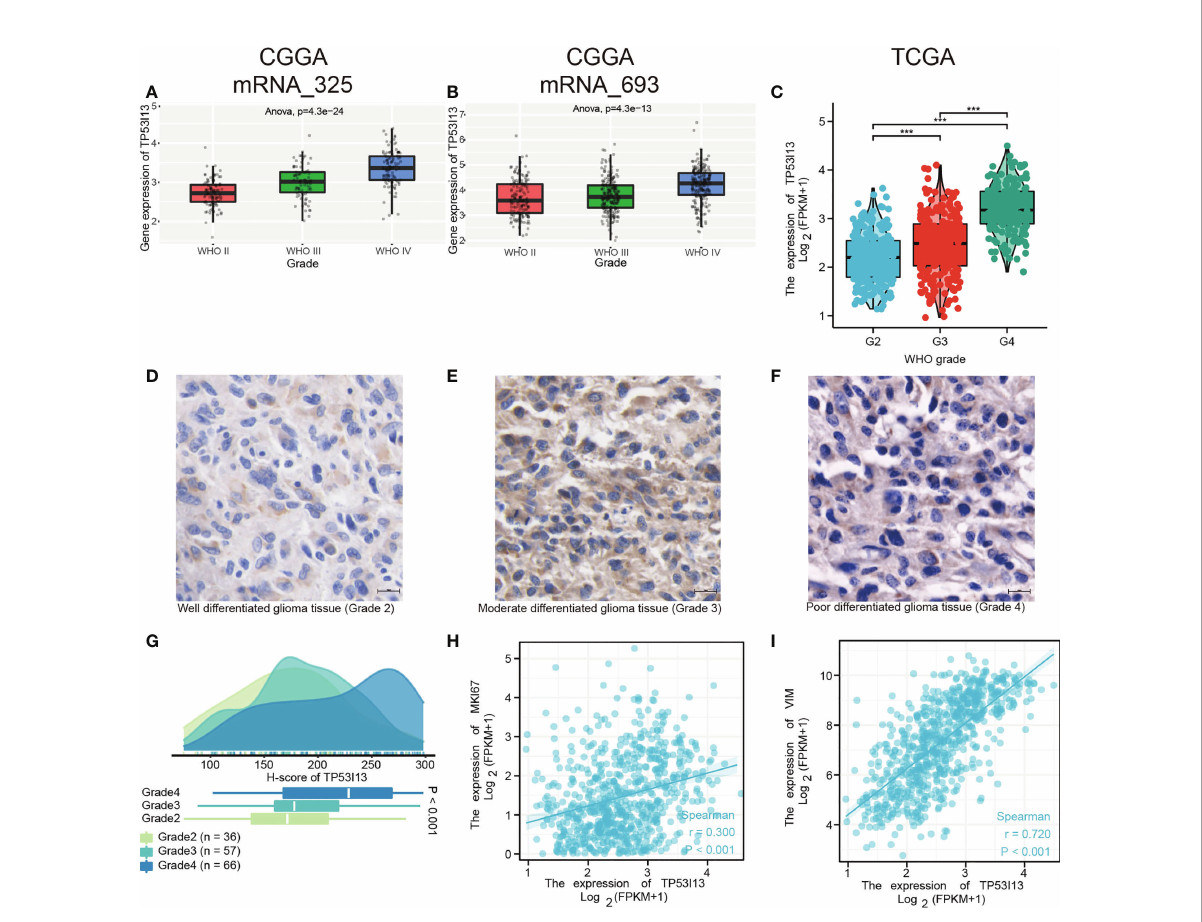
FIGURE 4 TP53I13 Expression in subgroups of glioma patients based on IDH mutation status, WHO grade, and 1p/19q codeletion status. Boxplot shows a correlation between TP53I13 expression and WHO grade based on (A) the CGGA mRNAseq_325 dataset, (B) the CGGA mRNAseq_693 dataset, and (C) the TCGA database. (D-F) IHC of TP53I13 in glioma tissues of different WHO grades. (G) Quanti fi cation of TP53I13 staining in glioma tissues of different WHO grades. (H) The relationship between TP53I13 and a proliferation marker (Ki-67). (I) The relationship between TP53I13 and invasion markers